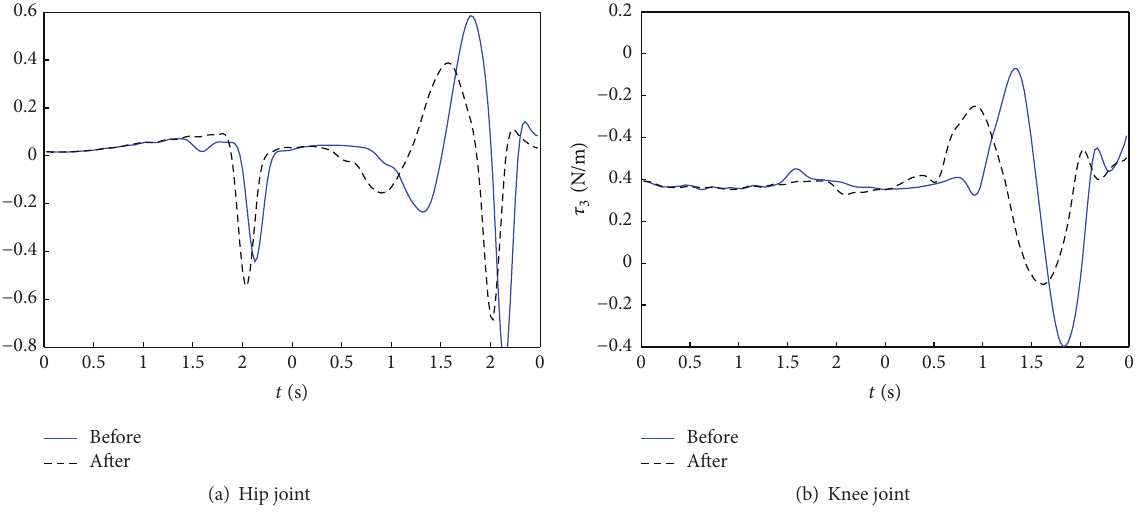
Figure 8: Variations of joint torques.